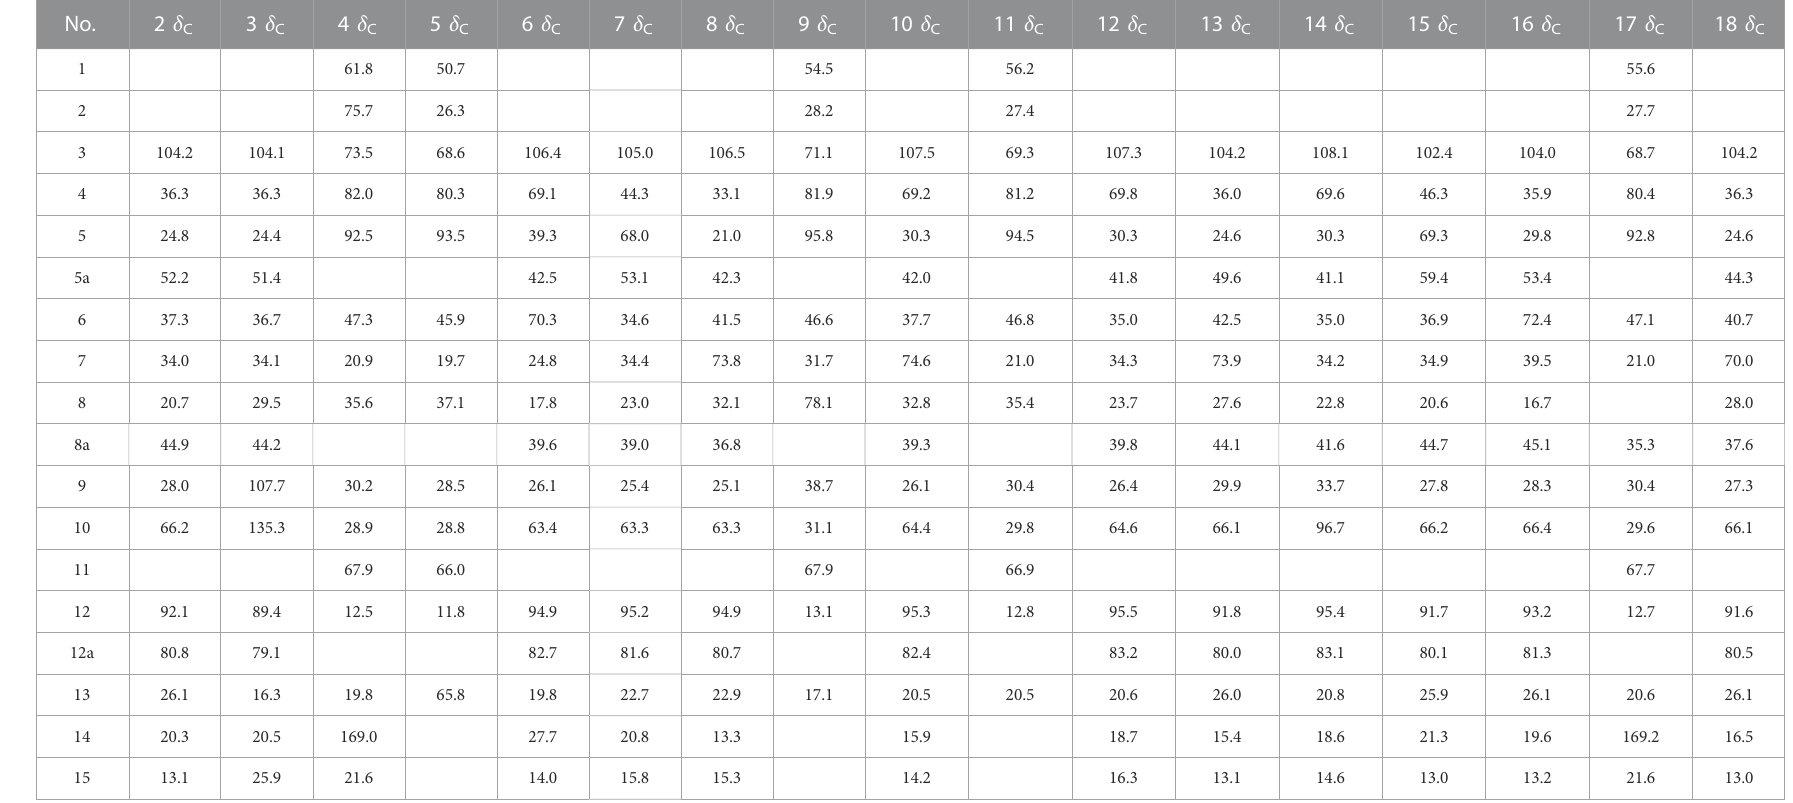
TABLE 1 13 C-NMR spectral data ( δ ) for compounds 2 – 18